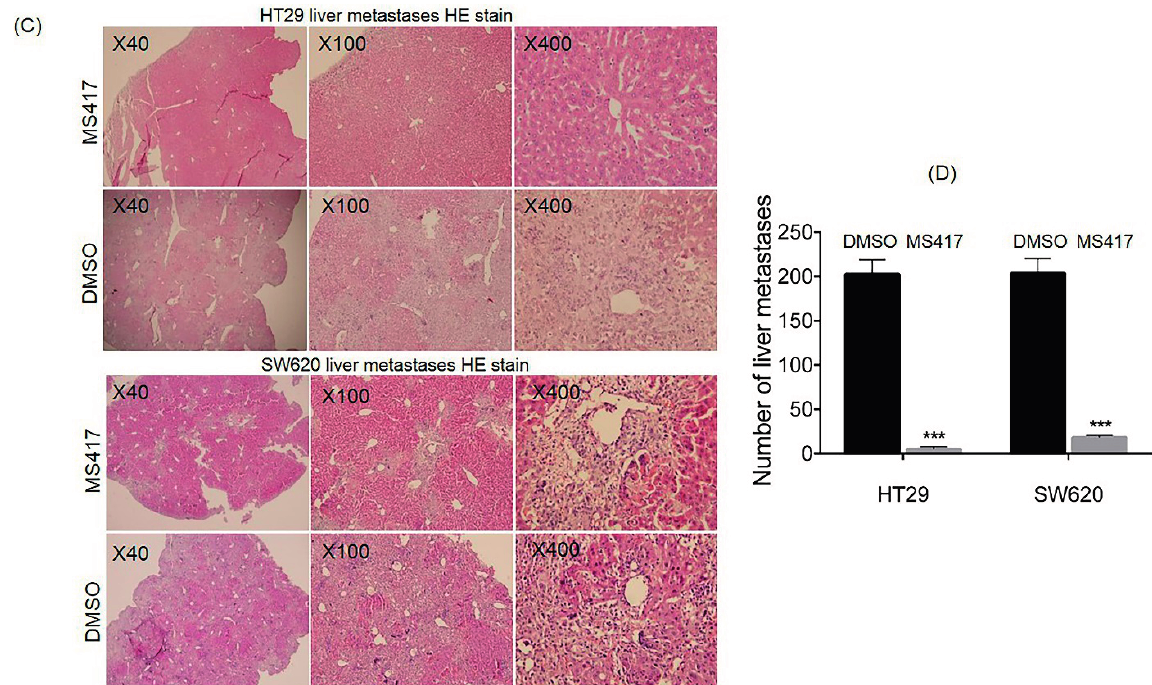
Figure 5. BRD4 inhibition suppresses CRC liver metastasis in vivo . ( A , B ) Macroscopic images of resected livers at the conclusion of the experiment in mice injected by HT29 or SW620 cell lines and then treated by vehicle/MS417 (20 mg/kg, n = 5/treatment); ( C , D ) Representative microscopic H&E images of livers. Metastatic focus is circled. *** p < 0.001. Values are depicted as Mean ±